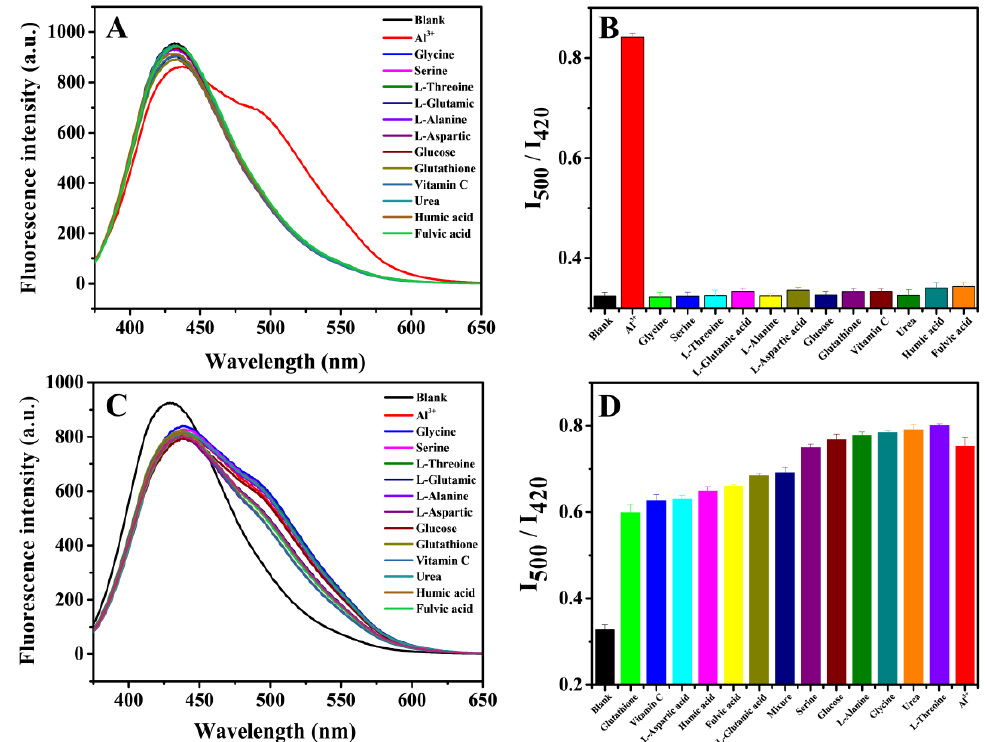
Figure 4. ( A , B ) The selectivity of the fluorescence method towards various small molecules. ( A ) Fluorescence spectra and ( B ) I 500 /I 420 variation of the CDs upon the addition of different small molecule. ( C , D ) Evaluation of the interference from various small molecules in the fluorescence method. ( C ) Fluorescence spectra and ( D ) I 500 /I 420 variation of the CDs-Al 3+ (307.69 µ M) upon the addition of different small molecule and the mixture of above small molecules. The concentration is 307.69 µ M for glycine, serine, L-threoine, L-glutamic, L-alanine, L-aspartic, glucose, glutathione, vitamin C, urea, and fulvic acid, and 247 µ g/mL for humic